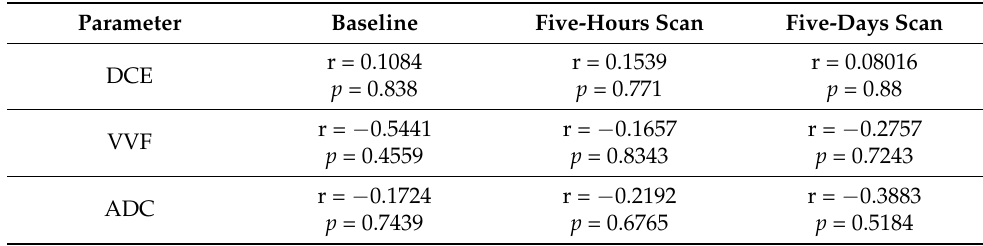
Table 1. Correlation between imaging parameters and mean vessel density. Neither DCE, VVF nor ADC correlate with the mean vessel density per µ m, as determined using immunohistochemical staining of the patients’ slices with ERG, CD31 and CD34. Therefore, assessment of the mean vessel intensity is not suitable for patient selection before therapy with tTF-NGR. Parameter Baseline Five-Hours Scan Five-Days Scan r = 0.1084 r = 0.1539 r = 0.08016 DCE p = 0.838 p = 0.771 p = 0.88 r = − 0.5441 r = − 0.1657 r = − 0.2757 VVF p = 0.4559 p = 0.8343 p = 0.7243 r = − 0.1724 r = − 0.2192 r = − 0.3883 ADC p = 0.7439 p = 0.6765 p =